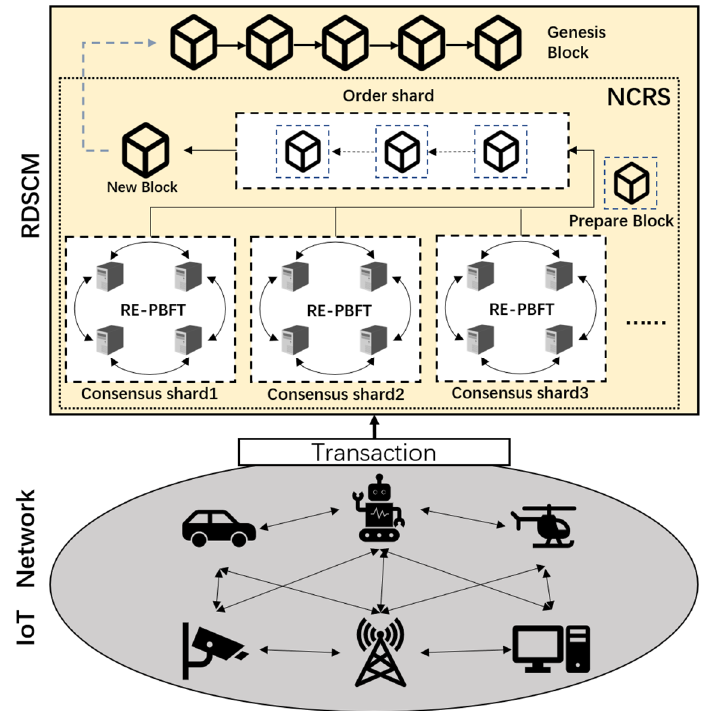
Figure 1. RDSCM applied in IoT network.